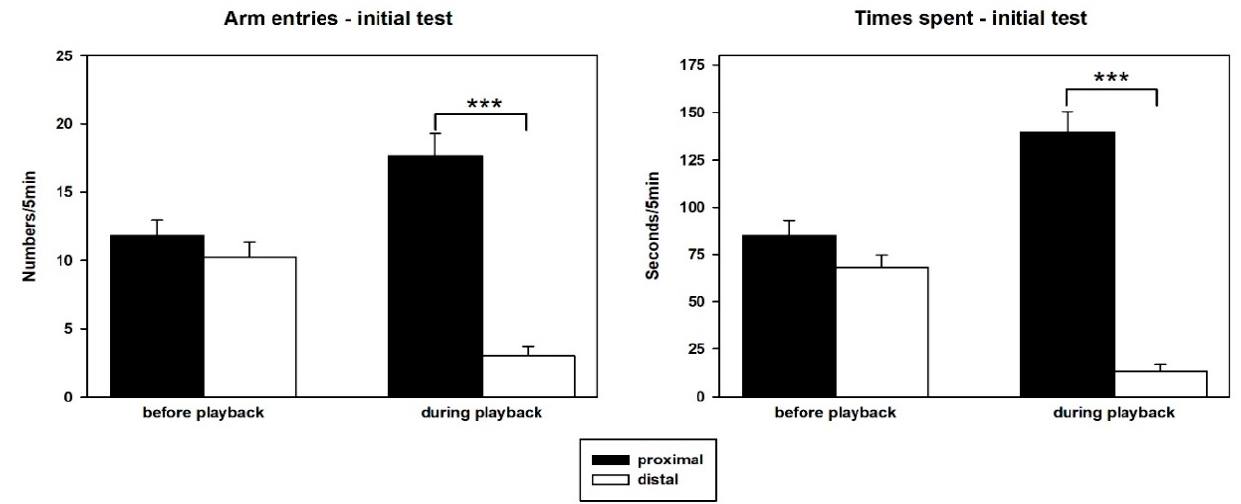
Figure 3. Behavioral responses elicited by playback of 50 ‐ kHz USV during the initial test. Behavioral responses were quantified as arm entries ( left graph ) and times spent on arms ( right graph ) proximal to (black) or distal from the sound source (white) during the 5 min of 50 ‐ kHz USV playback. Data are presented as means + SEM. *** p < 0.001 for proximal versus distal values.